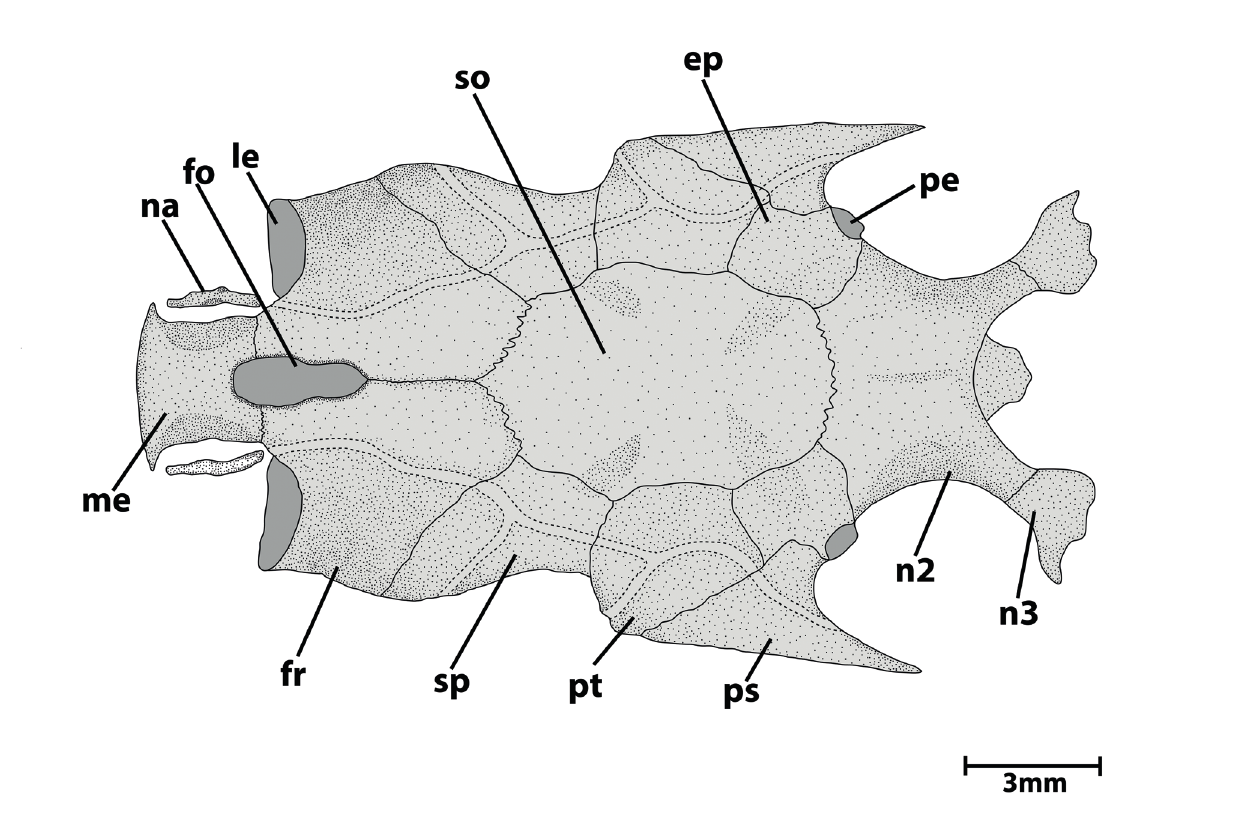
FIGURE 2 | Neurocranium of Tatia akroa , UFOPA-I 670, 34.3 mm SL. Dorsal view. Abbreviations: ep , epioccipital; fo , cranial fontanel; fr , frontal; le , lateral ethmoid; me , mesethmoid; na , nasal; n2 , second nuchal plate; n3 , third nuchal plate; pe , pterotic; ps , posttemporal- supracleitrum; pt , pterotic; so , supraoccipital; sp , sphenotic. Scale bar = 3